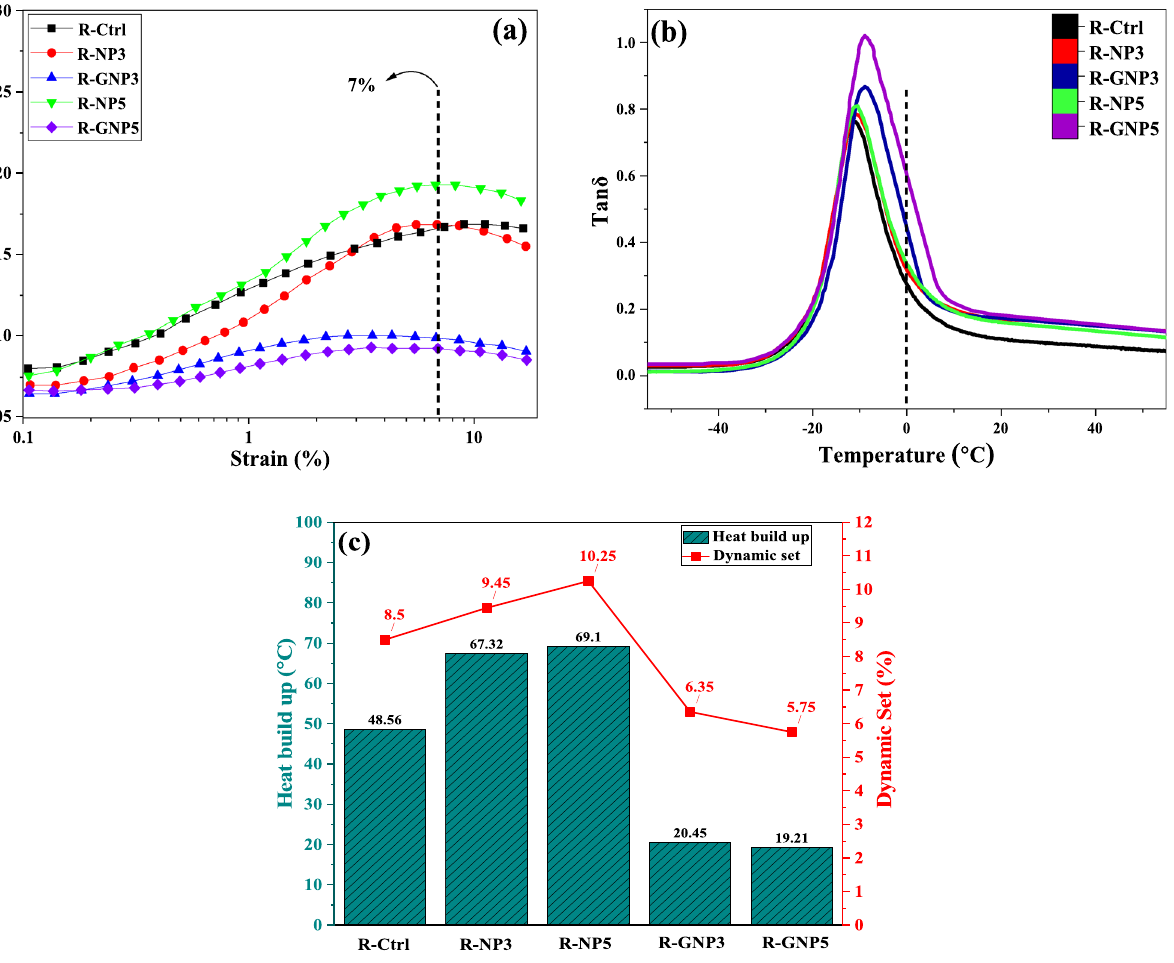
Figure 13. Dynamic mechanical performances of NBR/silica composites: ( a ) loss factor (tanδ-strain), ( b ) loss factor (tanδ-temperature) and ( c ) Heat buildup and dynamic